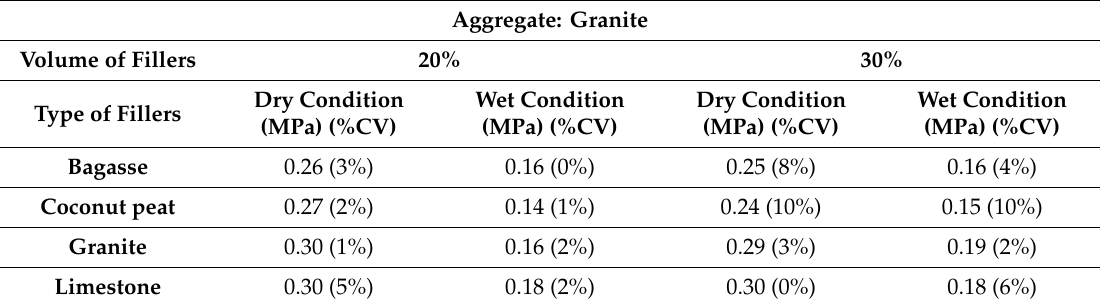
Table 3. ITS of dry and wet conditions on asphalt mixtures with granite and di ff erent filler contents (i.e., 20% and 30% by